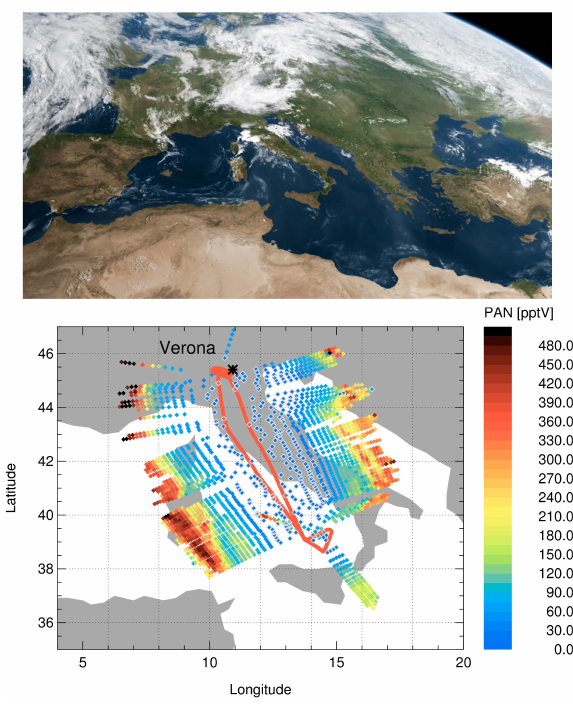
Fig. 2. Upper panel: satellite image of cloud coverage on 29 July 2006, 08:00UTC, true color image from MSG SEVIRI data, see Reuter and Pfeifer (2011). Lower panel: flight track (red line) and approximated horizontal measurement positions color coded with the PAN mixing ratios as retrieved for the AMMA flight on 29 July 2006. Most structures in the PAN distribution rather represent the vertical distribution shown in Fig.